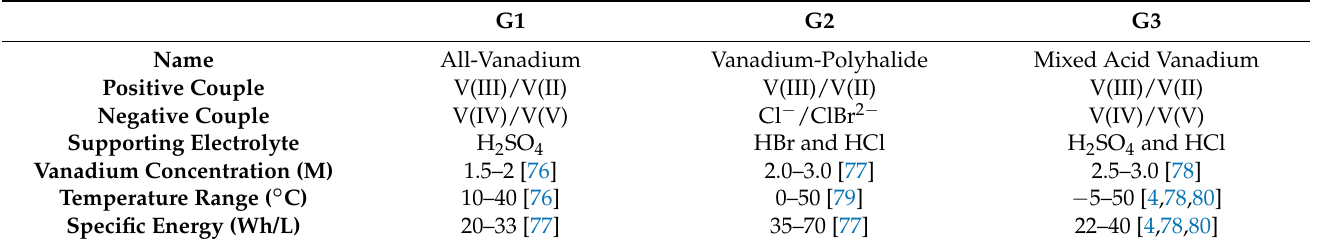
Table 2. Comparison between the three generations of RFBs (G1, G2, and G3). G1 G2